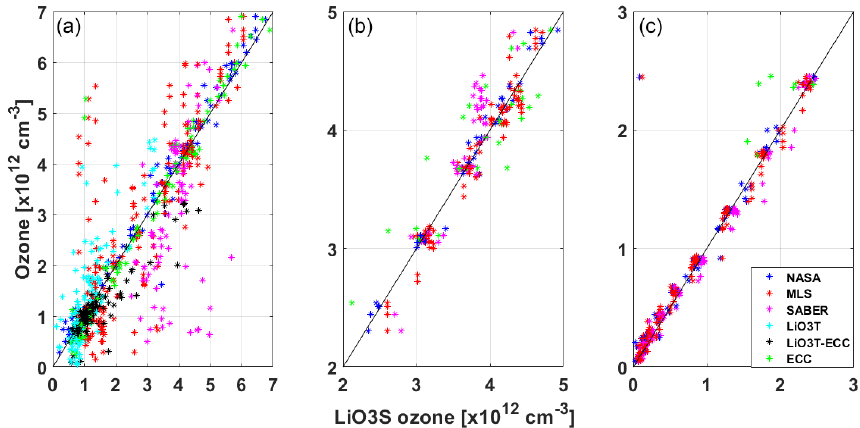
Figure 8. Scatter plots of ozone concentration as measured by the various LAVANDE instruments (along the vertical axis) and ozone measured by the LiO 3 S (along the horizontal axis). (a) Ozone from 0 to 20km altitude. (b) Ozone from 20 to 30km altitude. (c) Ozone from 30 to 50km